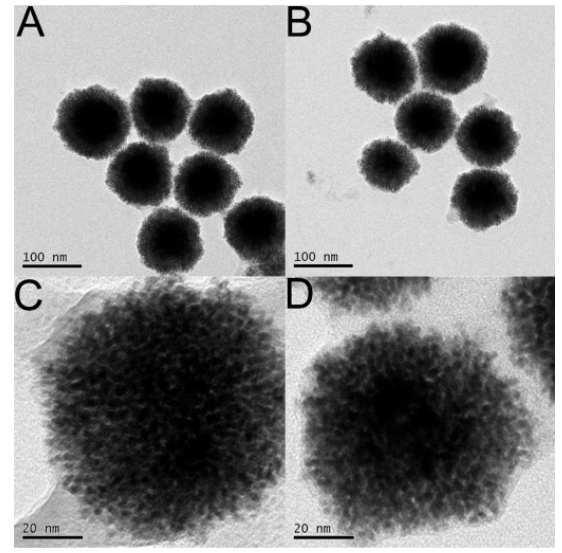
Figure 4. Trimetallic Pt ‐ Au ‐ Ru NPs constructed with the promising intermetallic phase for improving the fuel cells oxidation reaction ( A–D ). Reproduced from [54], with permission from Elsevier, 2018.